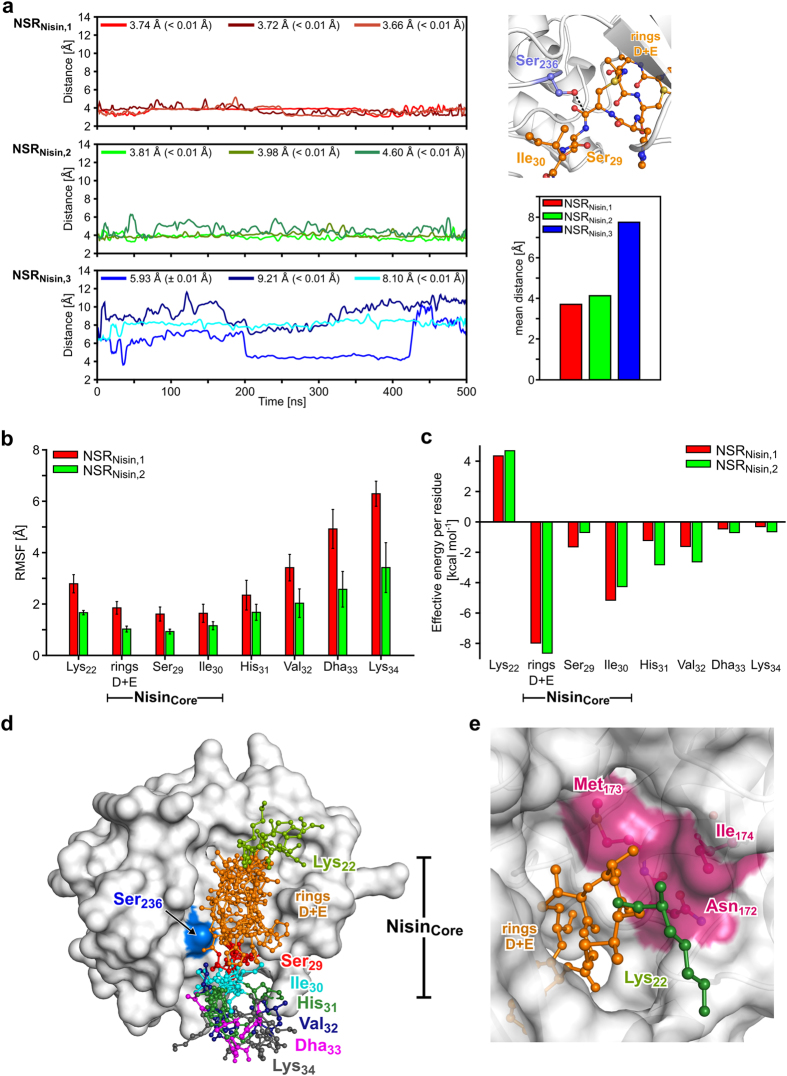
Structural and energetic analysis of MD simulations of SaNSR/nisin model complexes.(a) Distance between the side chain oxygen of Ser236 and the carbonyl carbon of ring E at the nisin cleavage site (black dotted line in the upper right panel) in NSRNisin, {1, 2, 3} during 500 ns of MD simulations; lines were smoothed by cubic splines. Mean values and standard error of the mean (SEM; in parentheses) are shown in the legend. The mean distance over all three MD simulations is shown in the lower right panel (SEM < 0.1 Å and not shown). (b) Mean backbone RMSF (SEM indicated as error bars) for NSRNisin, {1, 2} models over three trajectories each of 500 ns length. Rings D and E, Ser29, and Ile30 compose the NisinCore. (c) Mean effective binding energy per residue for NSRNisin,{1, 2} models. Error bars indicate SEM over three trajectories. (d) Superimposition of six close-to-average structures (based on the backbone RMSD) of nisin (ball-and-stick models each colored differently), extracted from three independent MD simulations each of NSRNisin,1 and NSRNisin,2, within the tunnel of SaNSR (white surface representation). Ser236 of the catalytic dyad is colored in blue. For clarity, the N-terminal helical bundle and part of the cap region of SaNSR have been omitted. (e) Representative nisin model (orange and green ball-and-stick model) within the tunnel of SaNSR (white cartoon representation with transparent surface). Residues Asn172, Met173, and Ile174 that bind to rings D and E are colored in magenta.